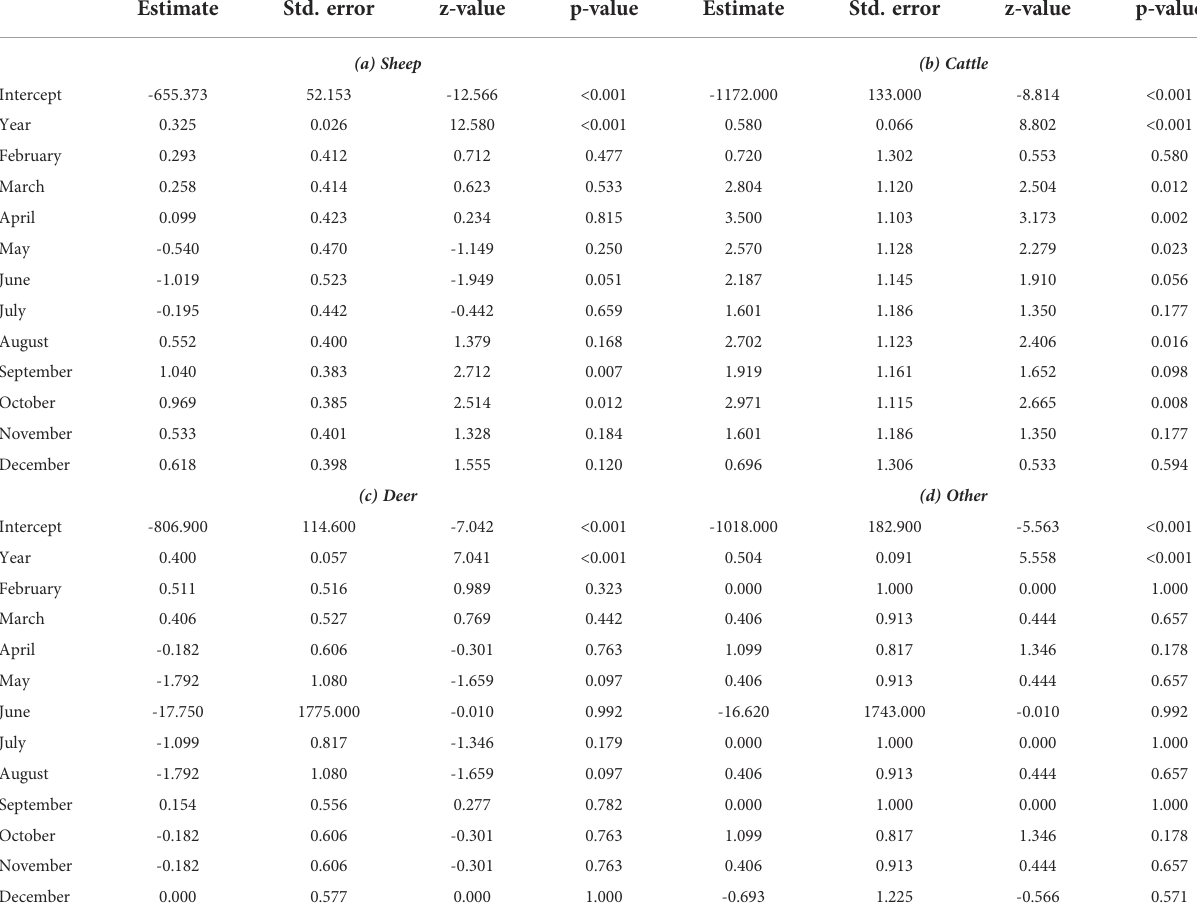
TABLE 2 Summary statistics of count regression models, testing the effect of year and month on the number of reported predation events on (a) sheep, (b) cattle, (c) farmed deer, and (d) other species by wolves in Brandenburg State (Germany).